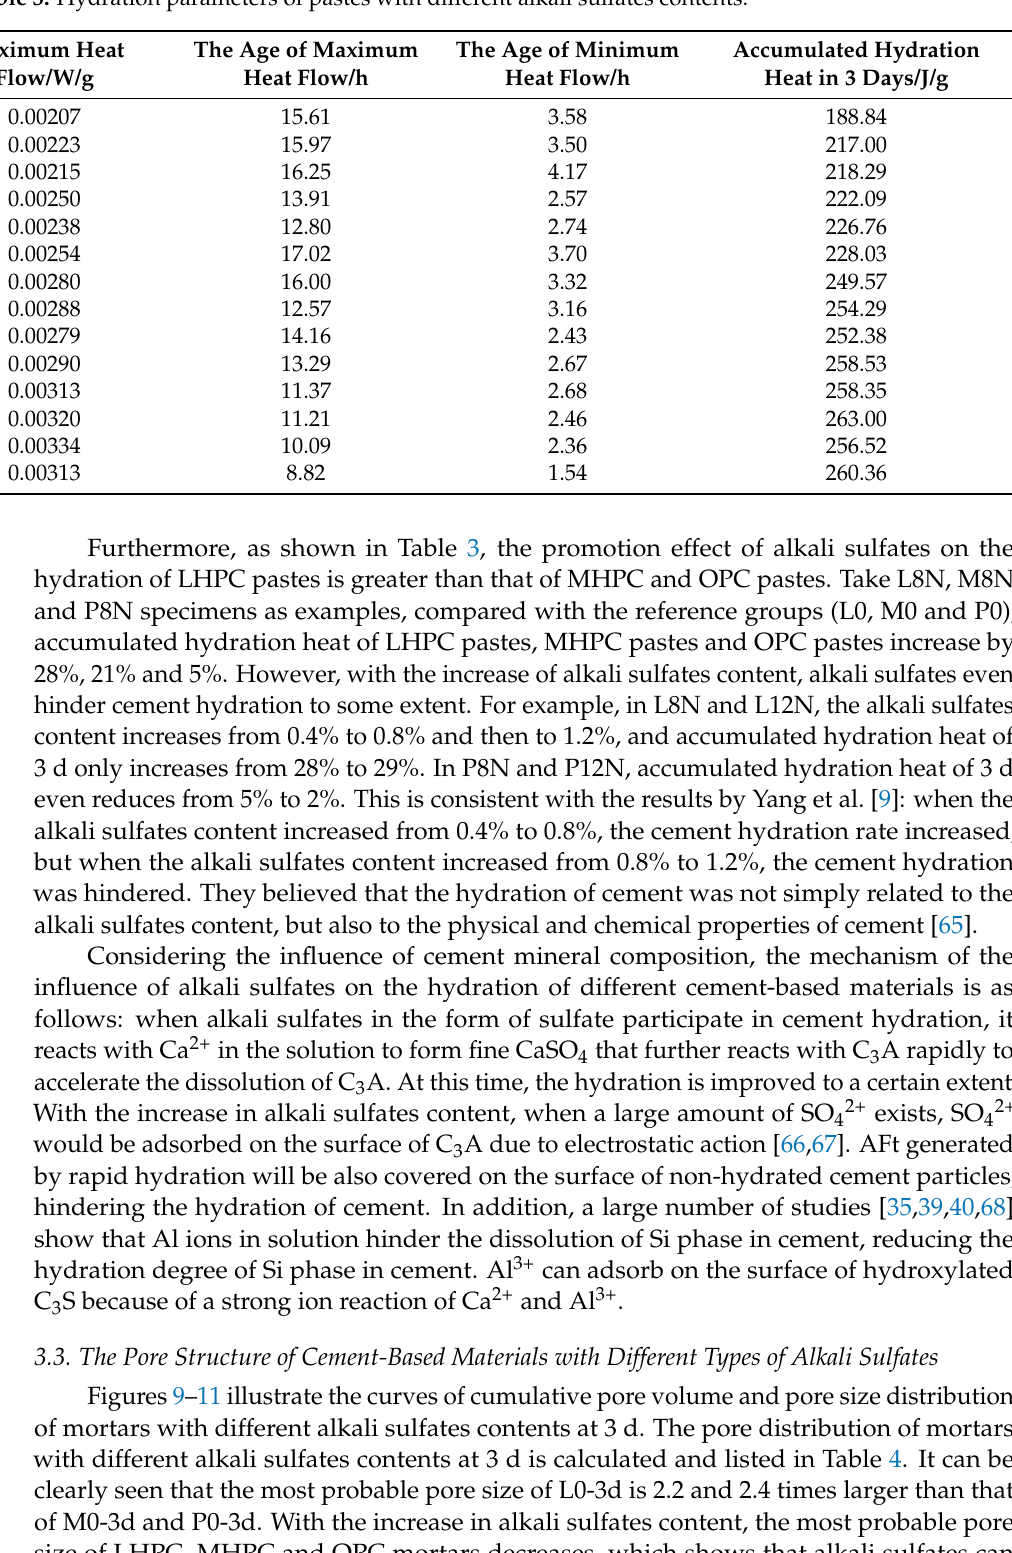
Table 3. Hydration parameters of pastes with different alkali sulfates